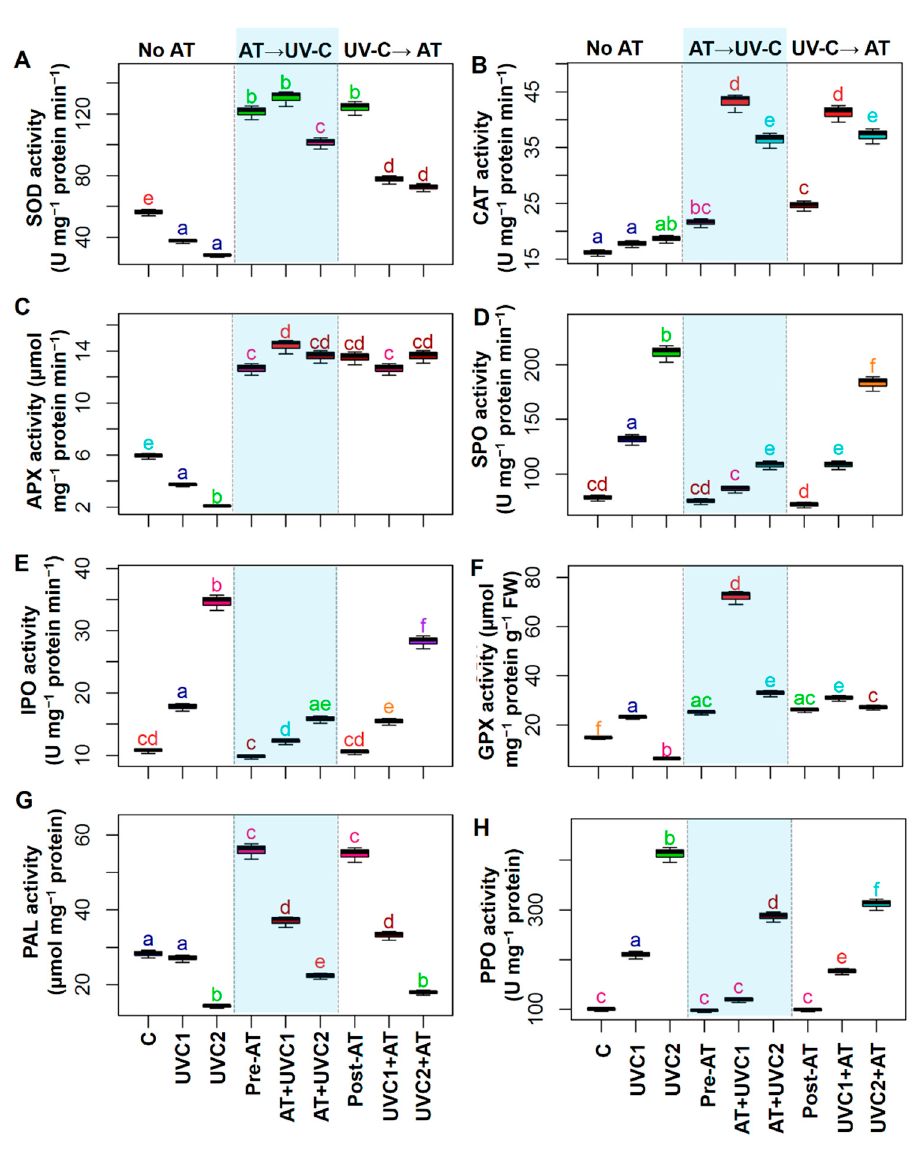
Figure 4. Effects of pre-treatment and post-treatment of allantoin (AT) on superoxide dismutase (SOD) activity ( A ), catalase (CAT) activity ( B ), ascorbate peroxidase (APX) activity ( C ), soluble peroxidases (SPO) activity ( D ), ionic peroxidases (IPO) activity ( E ), glutathione peroxidase (GPX) activity ( F ), phenylalanine ammonia-lyase (PAL) contents ( G ), and polyphenol oxidase (PPO) activity (PPO) ( H ) in tomato plants grown 15 days in presence and absence of UVC stress. Each boxplot shows values of five independent replicates ( n = 5). Boxplots specified with the same letter(s) are statistically non-significant at p < 0.05 based on Tukey’s test. Treatments are the same as Figure 1.